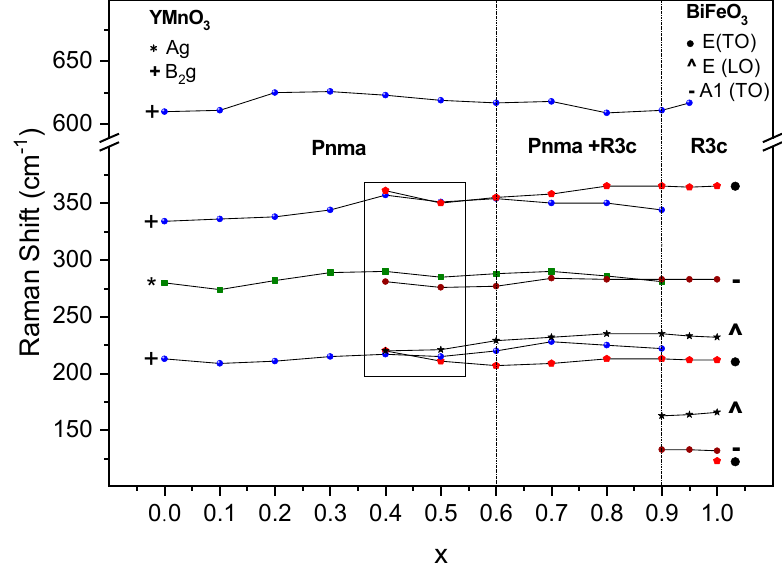
Figure 7. Position of selected Raman modes throughout the (1 − x)YMnO 3 –xBiFeO 3 system. Regions defined with Raman compare well with those defined with XRD, although the width of the coexistence region is expanded down to x = 0.4. Note that these techniques have different spatial resolutions, and that Raman is sensitive to very short-ranged structural orders that are beyond XRD